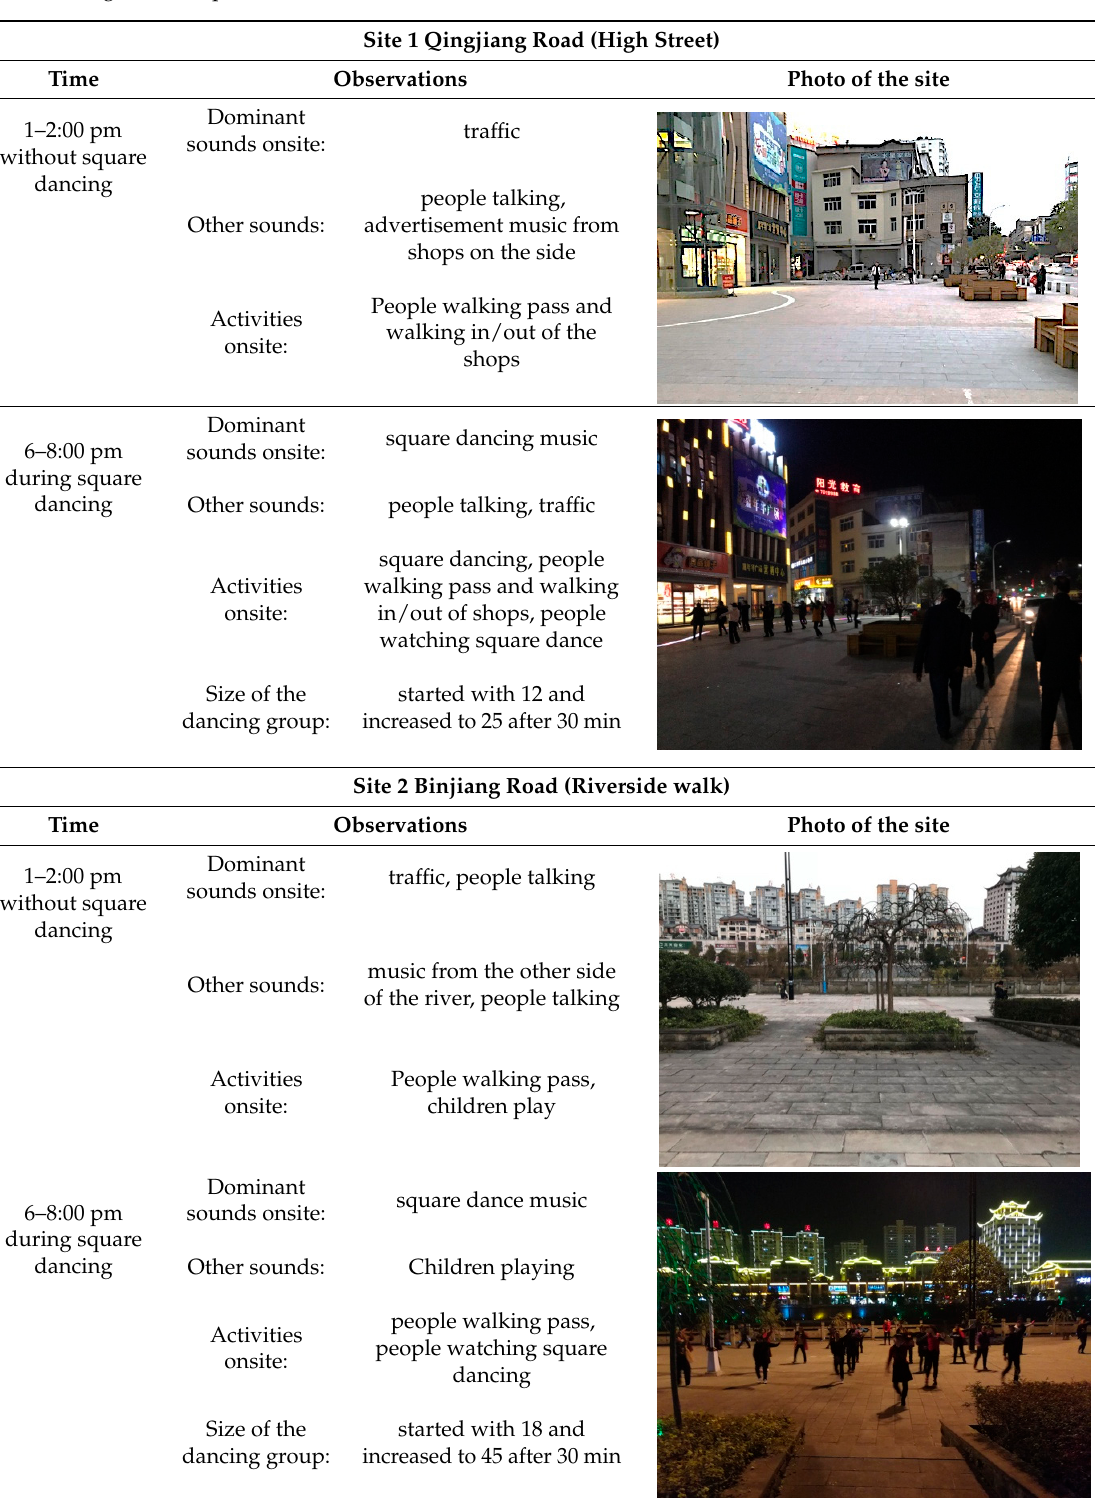
Table 1. Observation notes and photos of sites during square dancing at 6–8:00 pm and without square dancing at 1–2:00 pm.